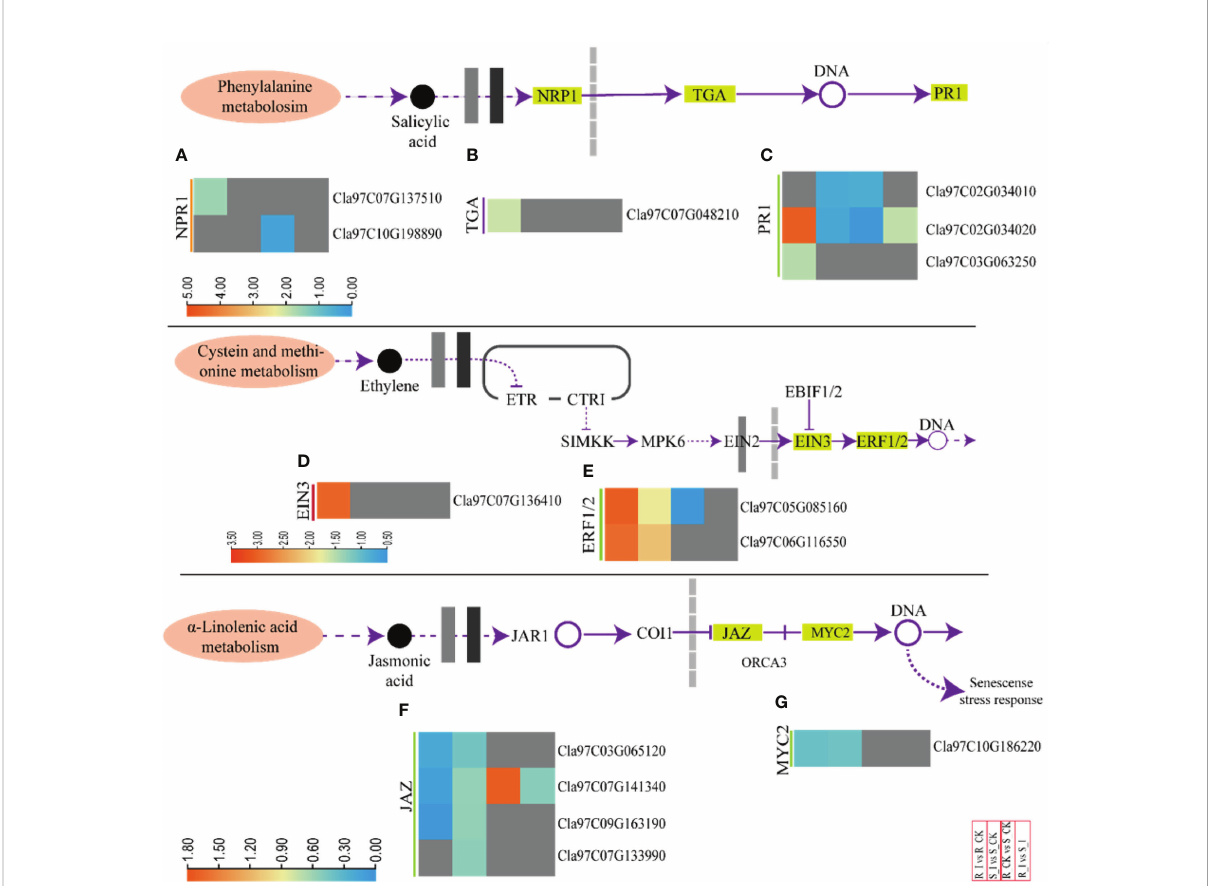
FIGURE 7 A heatmap of the genes related to phytohormone defense related activities with differential expression after PM infection in susceptible and resistant watermelon lines, over early stages of invasion in leaves. A heatmap shows DEGs from the NPR1 (A) , TGA (B) , PR1 (C) , EIN3 (D) , ERF1/2 (E) , JAZ (F) , and MYC2 (G) gene families from the different comparison groups R_I vs.. R_CK, S_I vs.. S_CK, R_CK vs.. S_I, and R_I vs.. S_I. The Log FC values corresponding to each gene in a group are used to generate a heatmap. The red and blue colours specify up-and down- regulated